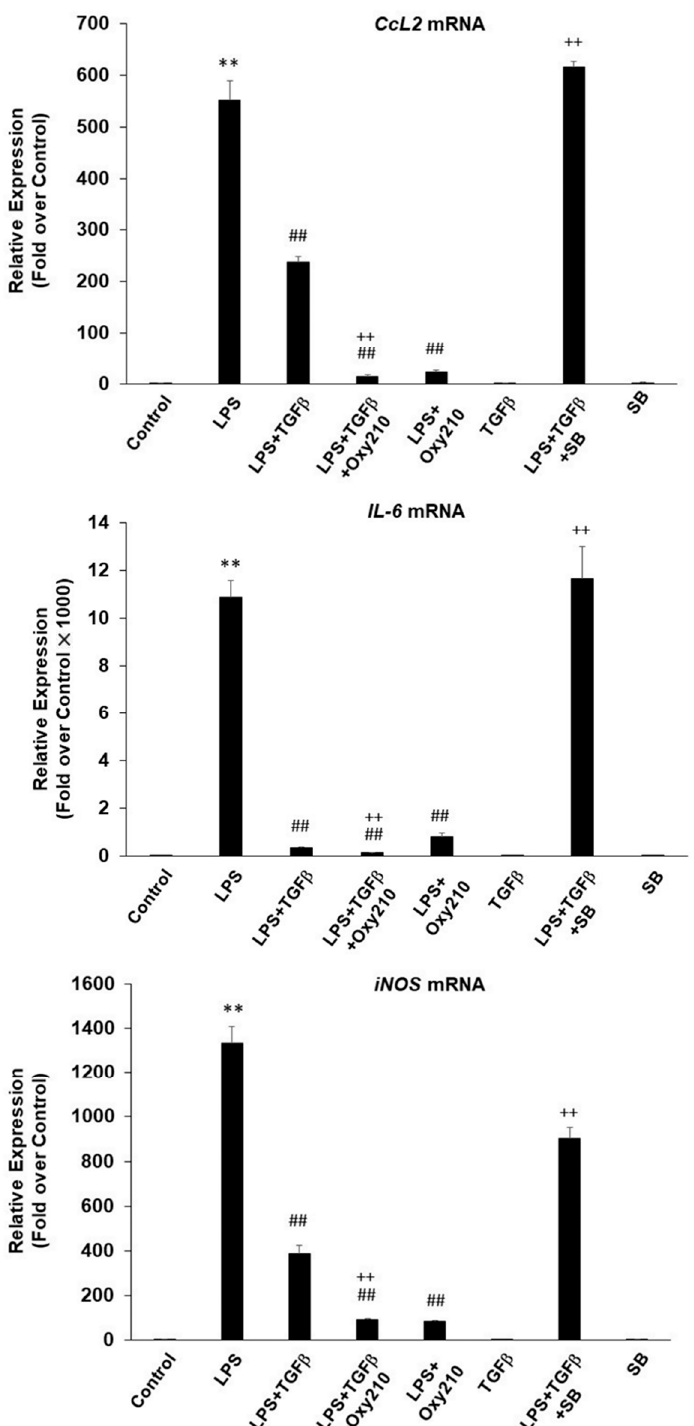
Figure 13. Enhancement of the anti-inflammatory effect of TGF- β in RAW264.7 mouse macrophages by Oxy210. RAW264.7 cells were pretreated with Oxy210 (5 µ M) or SB431542 (SB) (5 µ M) in DMEM containing 0.1% FBS for 24 h followed by the addition of TGF- β (10 ng/mL) for 2 h after which LPS (25 ng/mL) was added. After 24 h, RNA was extracted and analyzed by Q-RT-PCR for the expression of the genes as indicated and normalized to Oaz1 . Data from a representative experiment are reported as the mean of triplicate determinations ± SD (** p < 0.01 vs. control; ## p < 0.01 vs. LPS; ++ p < 0.01 vs. LPS+TGF- β ).